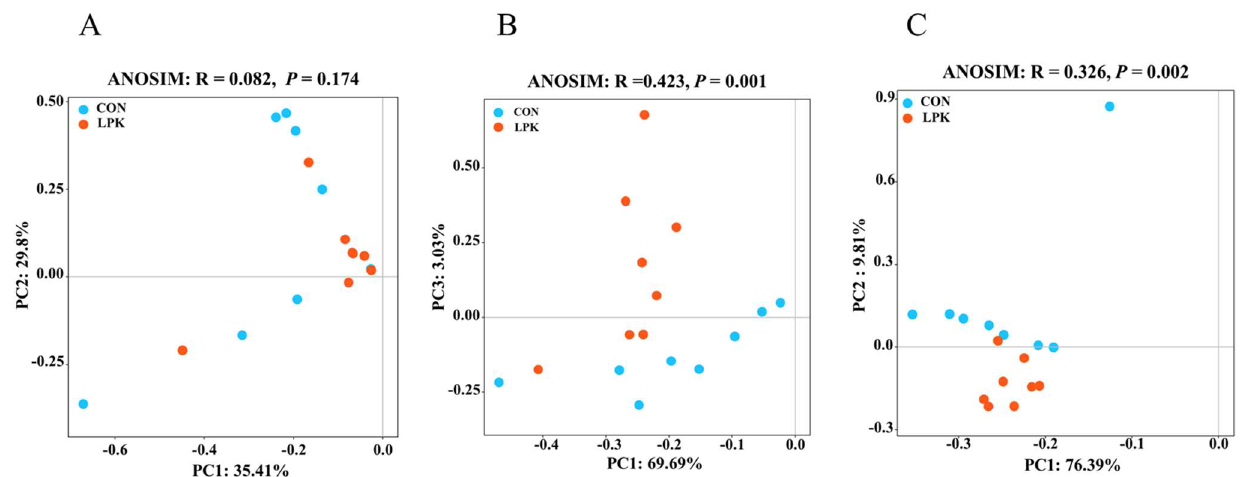
Figure 2. Principal coordinate analysis (PCoA) of rumen bacteria ( A ), protozoa ( B ), and fungi ( C ) based on operational taxon data. Control (CON) group (blue circle), live Pichia kudriavzevii (LPK) group (red circle).